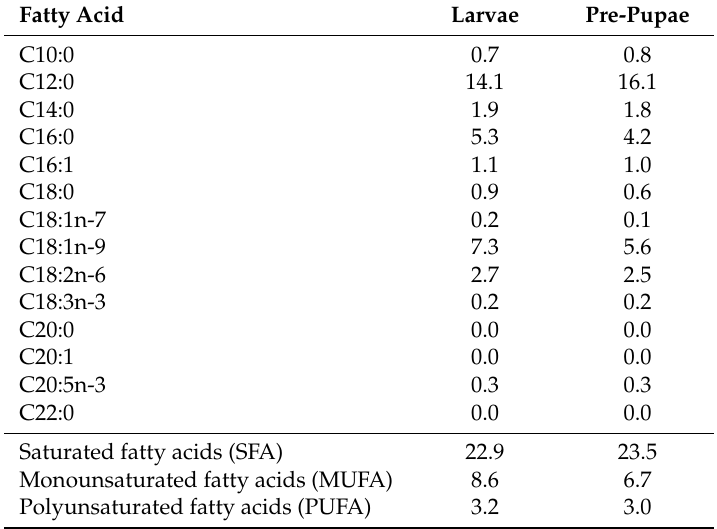
Table 4. Fatty acid concentration (% of dry matter) of black soldier fly larvae and pre-pupae.